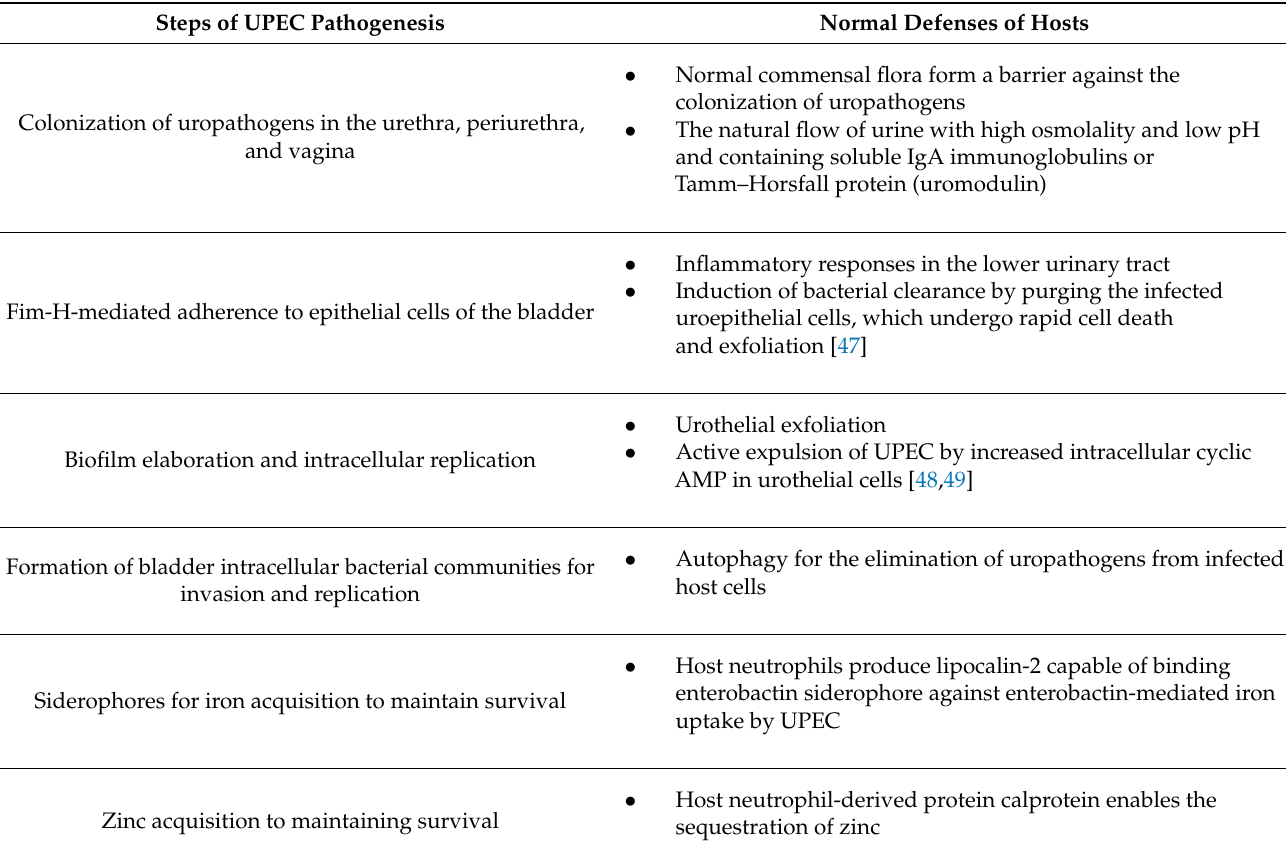
Table 4. The pathogenesis and defenses of the host with regard to acute cystitis and potential treatment